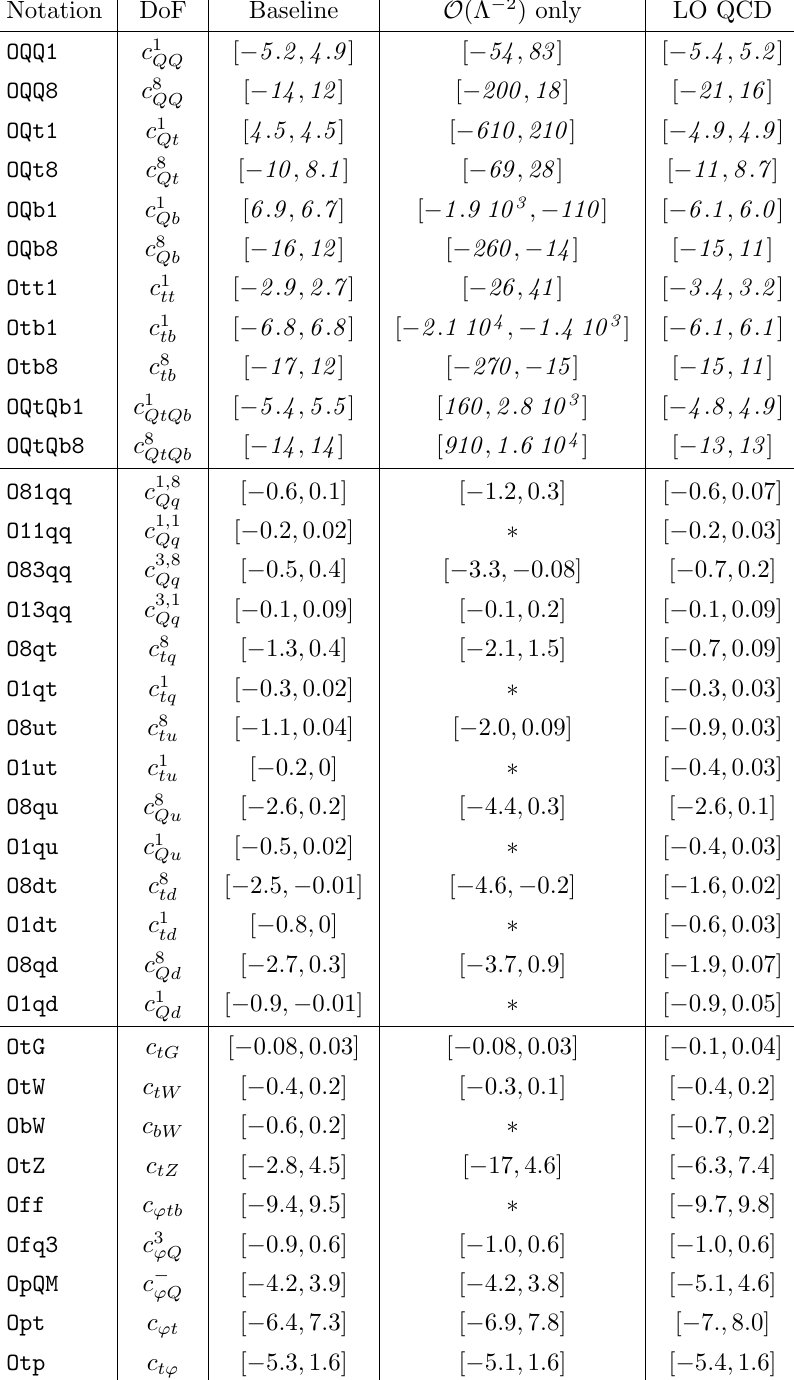
Table 10 . Same as table 9, now for the results of individual (cid:12)ts when only one operator is constrained at a time. The bounds in italics have been obtained from the analytical minimisation of the (cid:31) 2 rather than using the SMEFiT numerical approach, see text for more details.